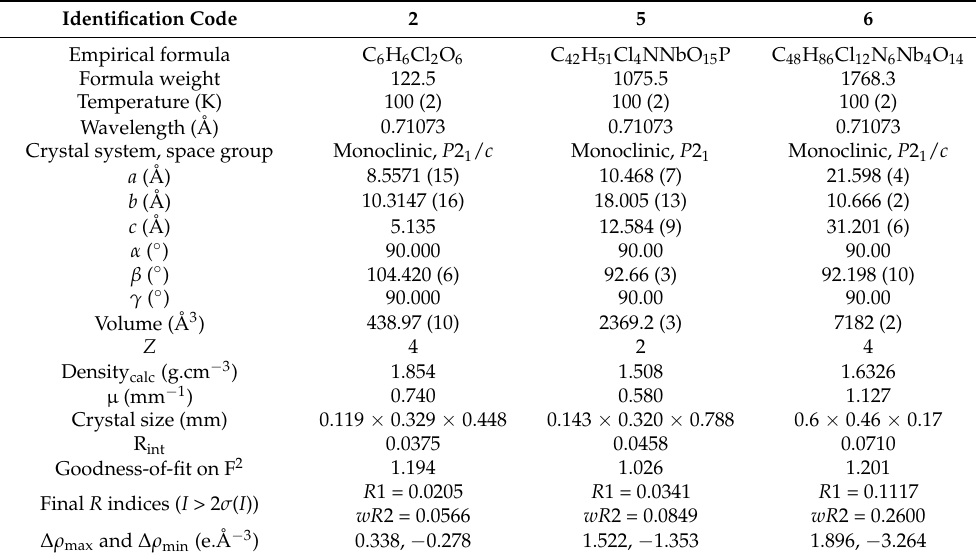
Table 1. Crystallographic data for (caH 2 ) · 2H 2 O ( 2 ), (Et 4 N) cis -[NbO(ca) 2 (H 2 O)OPPh 3 ] · 3H 2 O · THF ( 5 )